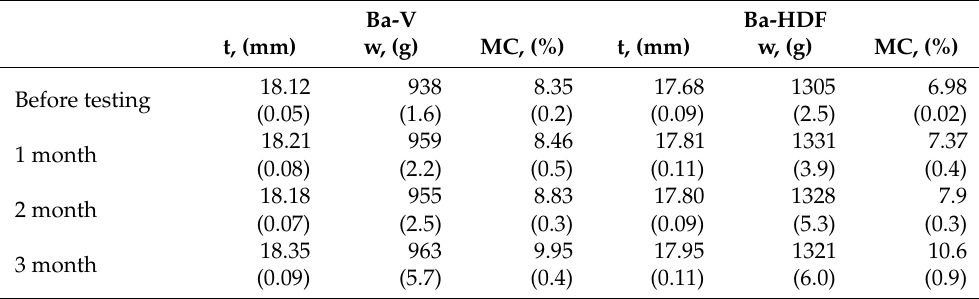
Table 4. Variation of the blockboards’ physical parameters during their exposure in the bathroom conditions (average values recorded for each